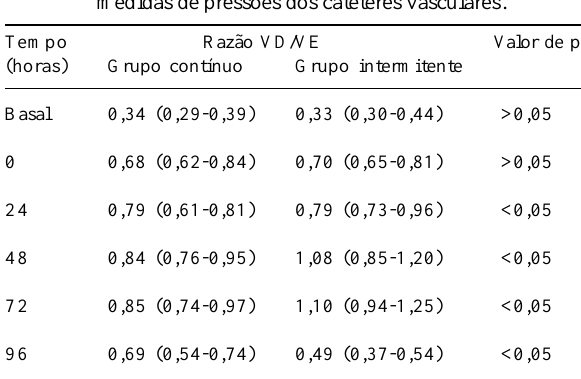
Tabela 1. Comparação das medianas da razão de pressões VD/VE nos grupos de sobrecarga sistólica contínua versus intermitente, calculada por meio dos dados obtidos pelas medidas de pressões dos cateteres vasculares.